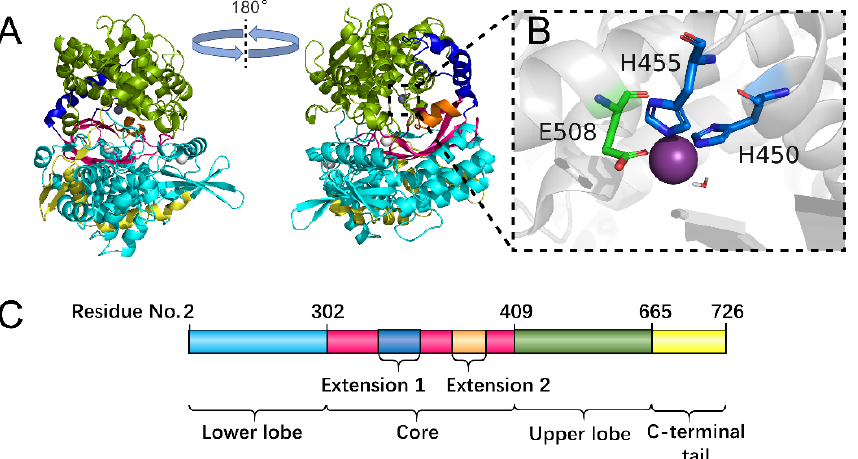
Figure 1. Overall structure of hDPP III. ( A ) Cartoon display of the hDPP III structure with different colors used in different domains. The lower lobe (residue number 2 to 302) is colored in cyan. The β -barrel catalytical core (residue number 303 to 409) is shown in hot pink. There are two α -helix extensions in the catalytical core (Extension 1: residue number 336 to 371; Extension 2: residue number 393 to 404) colored in blue and orange, respectively. The upper lobe with the Zn binding site is shown in green. The C-terminal tail (residue number 666 to 726) is colored in yellow. ( B ) Residues forming the Zn binding site are shown as sticks and the Zn atom is shown as a sphere. ( C ). Linear display of the residue number of each domain of hDPP III.